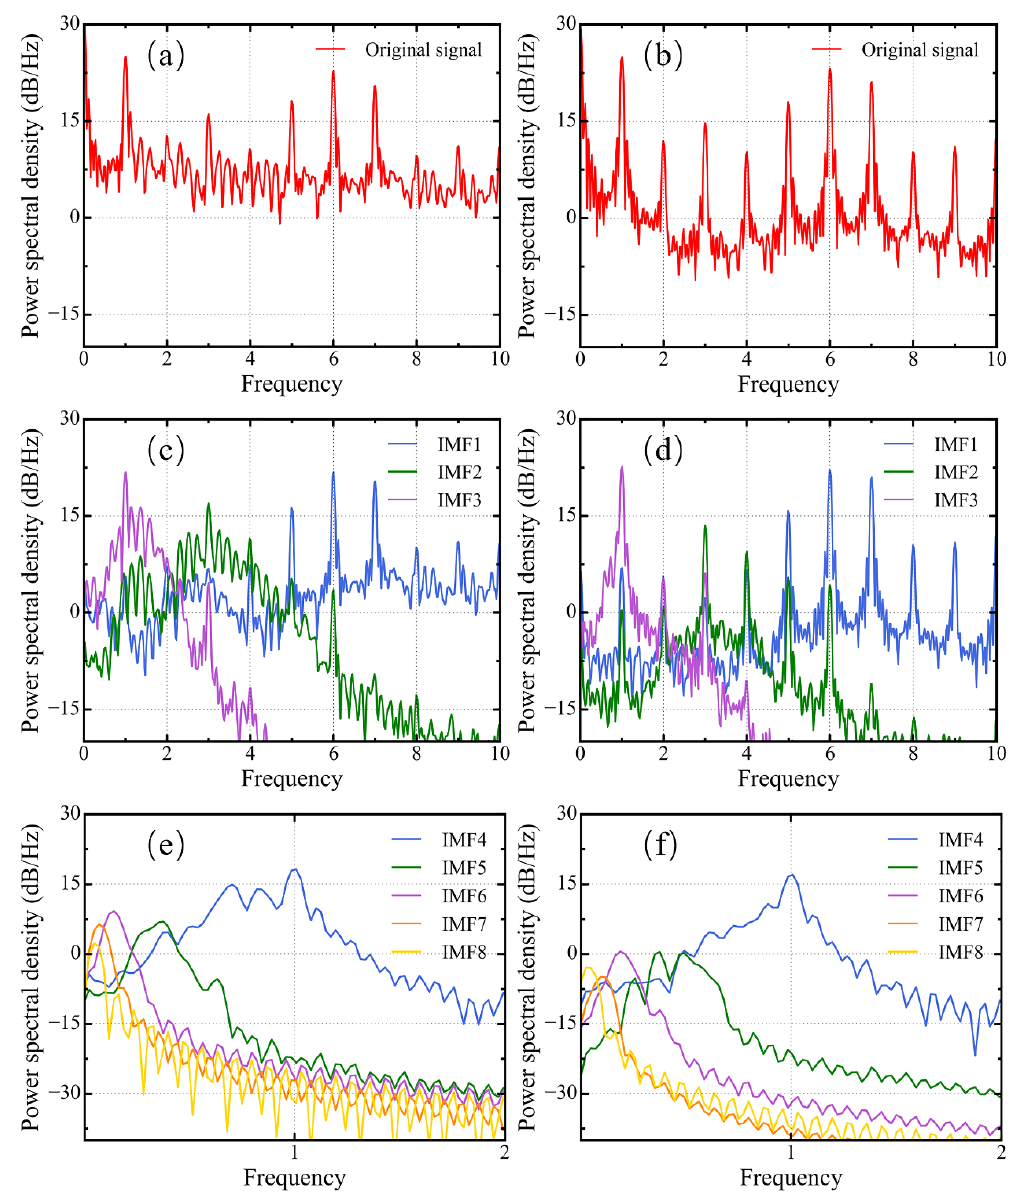
Figure 5. Spectra of ( a ) original signal, ( c ) IMF 1–3, and ( e ) IMF 4–8 of initial time series and spectra of ( b ) original signal, ( d ) IMF 1–3, and ( f ) IMF 4–8 of time series processed by Isolation Forest.